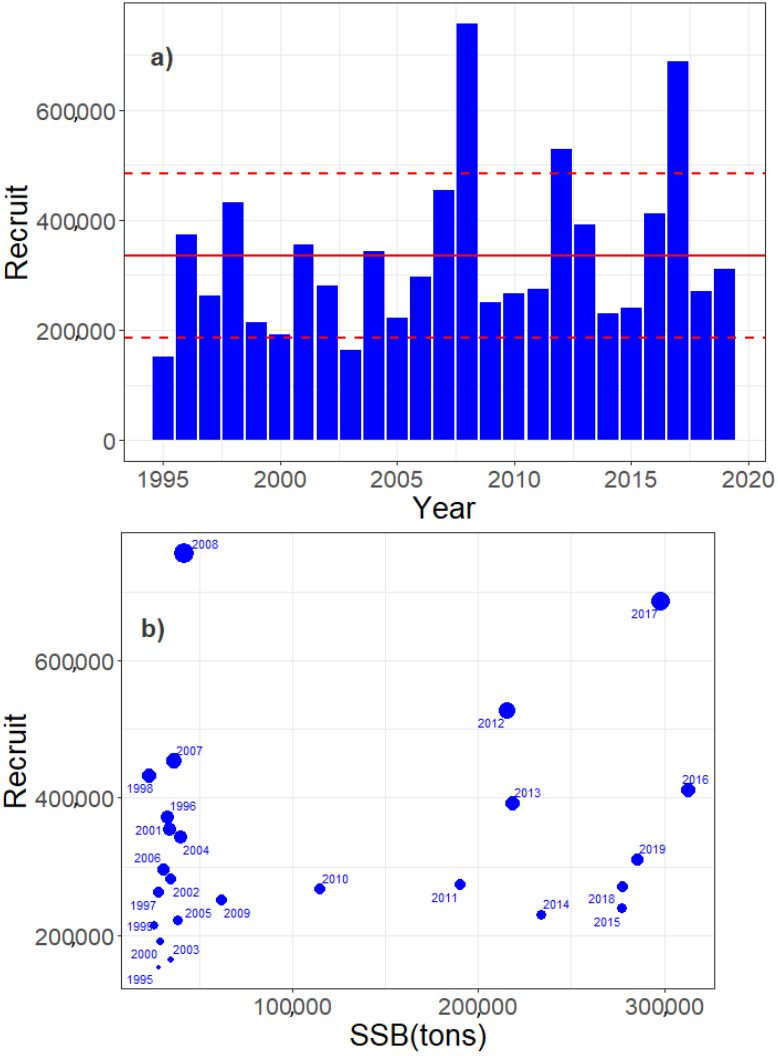
Figure 5. The ( a ) time series of recruitment and ( b ) the SSB–Recruit relationship of M. merluccius in the northern hake stock from 1995 to 2019. The red line indicates the mean recruitment value of the time series, and the red dashes represent the standard deviation. All the indicators are the output of the assessment model [37].